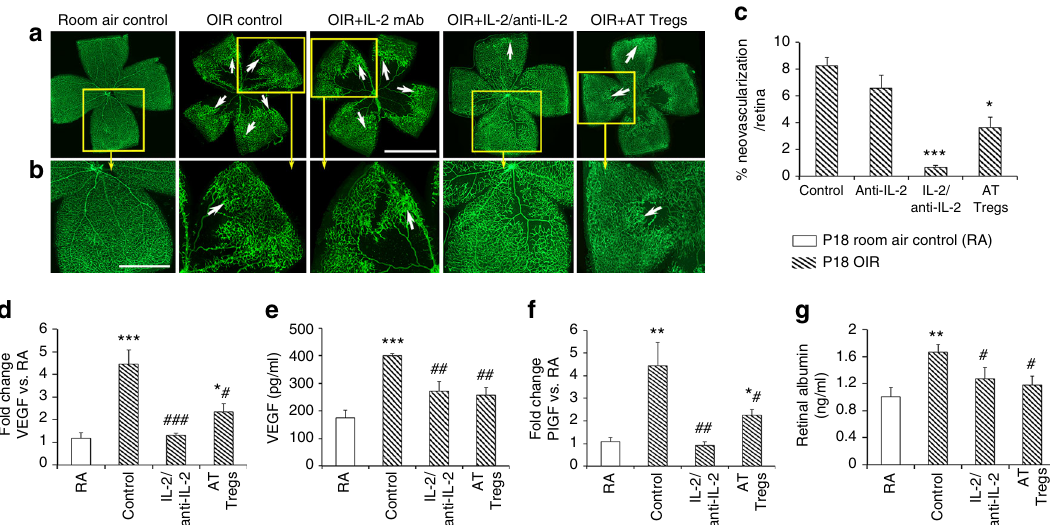
Fig. 4 Expanding Treg numbers reduced retinal neovascularization in OIR. a Representative confocal images of fl at mounted retina from C57BL/6J mice at postnatal day ( P ) 18 in phase II OIR and labeled with isolectin to show blood vessels ( green ). Scale bar , 0.5 mm. b One quadrant ( yellow box ) from each retina has been enlarged. Scale bar , 0.25 mm. Retinas from room air control (RA) mice exhibit normal vascularization, while retinas from OIR controls and OIR + anti-IL-2 mAb display marked neovascularization ( arrows ). OIR mice treated with an IL-2/anti-IL-2 mAb complex or adoptively transferred (AT) Tregs have reduced retinal neovascularization. c Neovascularization is expressed as a percentage of total retinal area. * P < 0.05, *** P < 0.001 to OIR control groups (one-way ANOVA with Mann – Whitney U test). n = 7 room air control mice and 9 mice/OIR group with three litters examined. d vegfa mRNA, e VEGF protein, f placental growth factor mRNA, and g vascular leakage were increased in retina from OIR mice compared to RA, and in OIR were reduced by both treatments. * P < 0.05, ** P < 0.01, and *** P < 0.001 to RA. # P < 0.05, ## P < 0.01, and ### P < 0.001 to OIR control (one-way ANOVA